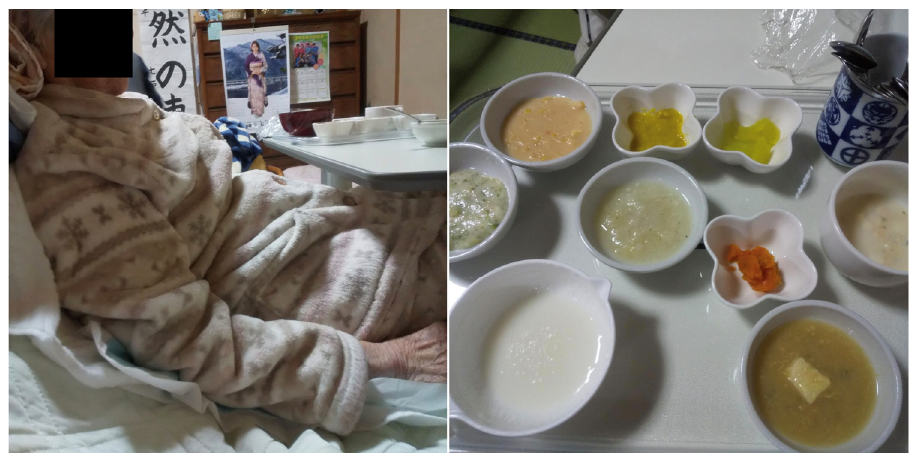
Figure 2. Positioning while eating ( left ) and meals (IDDSI Level 4) ( right ) at the first examination. To reduce the risk of aspiration and avoid compression of the lumbar spine, her bed was set at a 40° recline angle (Figure 3 left). The knees were bent lightly by placing cushions beneath the bottom of her feet (Figure 3 middle), and her head was stabilized, with the chin slightly pulled back using a bath towel (Figure 3 right).